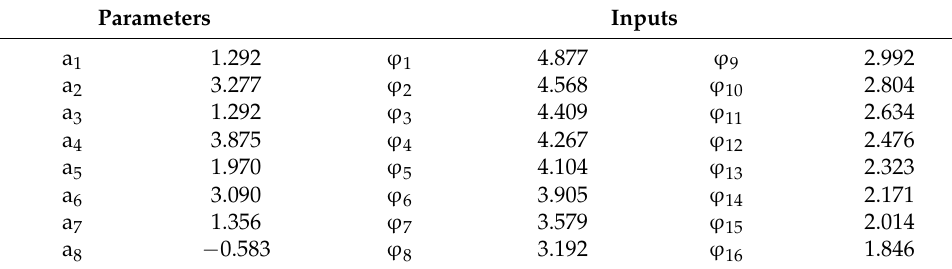
Table 2. Example 1: optimum design parameters and